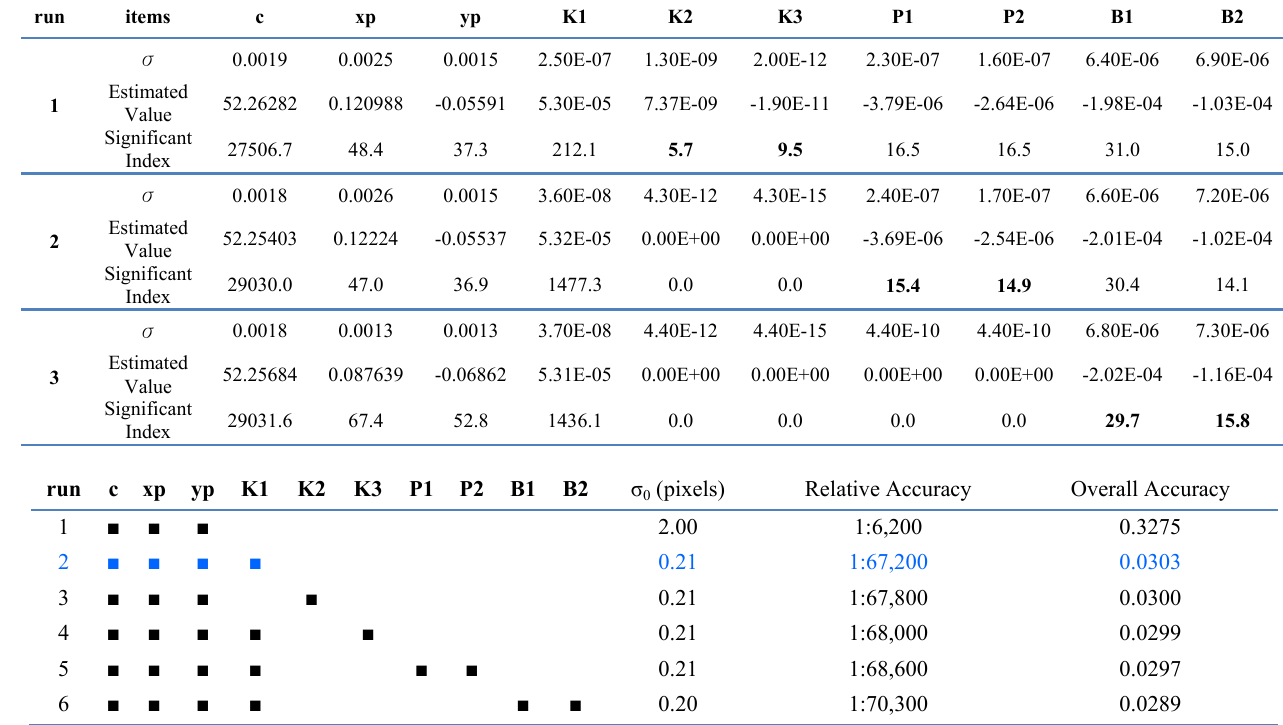
Table 1. Significance testing for the determination of additional